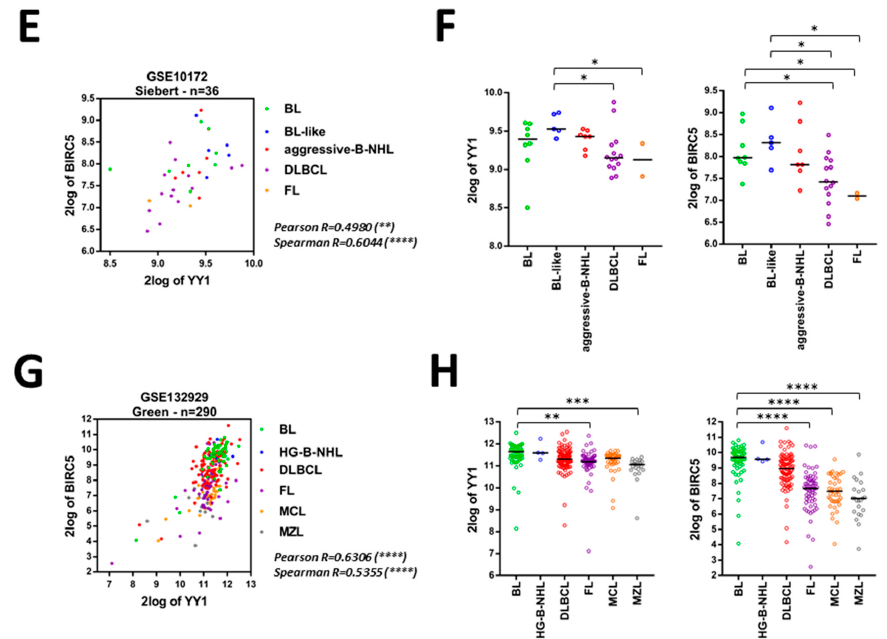
Figure 3. Correlation between YY1 and BIRC5 expression and relative YY1 and BIRC5 expression levels in di ff erent B-NHL subgroups, within 4 di ff erent B-NHL GEO Datasets. ( A ). GSE26673, Burkitt’s Lymphoma (BL), Pearson and Spearman correlation between YY1 and BIRC5 expression, patients stratified according to age (children, green; adult, blue). ( B ). GSE26673, dot plots of YY1 (left) and BIRC5 (right) expression with patients stratified by age (children, green; adult, blue). ( C ). GSE4475, B-NHL patients stratified based on molecular BL features (MBL green, intermediate-MBL blue, non-MBL red), Pearson and Spearman correlation between YY1 and BIRC5 expression. ( D ). GSE4475, dot plots of YY1 (left) and BIRC5 (right) expression with patients stratified based on molecular BL features (MBL green, intermediate-MBL blue, non-MBL red). ( E ). GSE10172, B-NHL patients stratified based on cancer type (BL green, BL-like blue, aggressive-B-NHL red, DLBCL purple, FL orange), Pearson and Spearman correlation between YY1 and BIRC5 expression. ( F ). GSE10172, dot plots of YY1 (left) and BIRC5 (right) expression with patients based on cancer type (BL green, BL-like blue, aggressive-B-NHL red, DLBCL purple, FL orange). ( G ). GSE132929, B-NHL patients stratified based on cancer type (BL green, HG-B-NHL blue, DLBCL red, FL purple, MCL orange, MZL grey), Pearson and Spearman correlation between YY1 and BIRC5 expression. ( H ). GSE132929, dot plots of YY1 (left) and BIRC5 (right) expression with patients based on cancer type (BL green, HG-B-NHL blue, DLBCL red, FL purple, MCL orange, MZL grey). Data in B, D, F, H are presented as dotted plots with Median ± SD. Significance was evaluated using one-way ANOVA with Tukey’s post-hoc comparison test (* P < 0.05; ** P < 0.01; *** P < 0.001; **** P < 0.0001; ns, not significant).